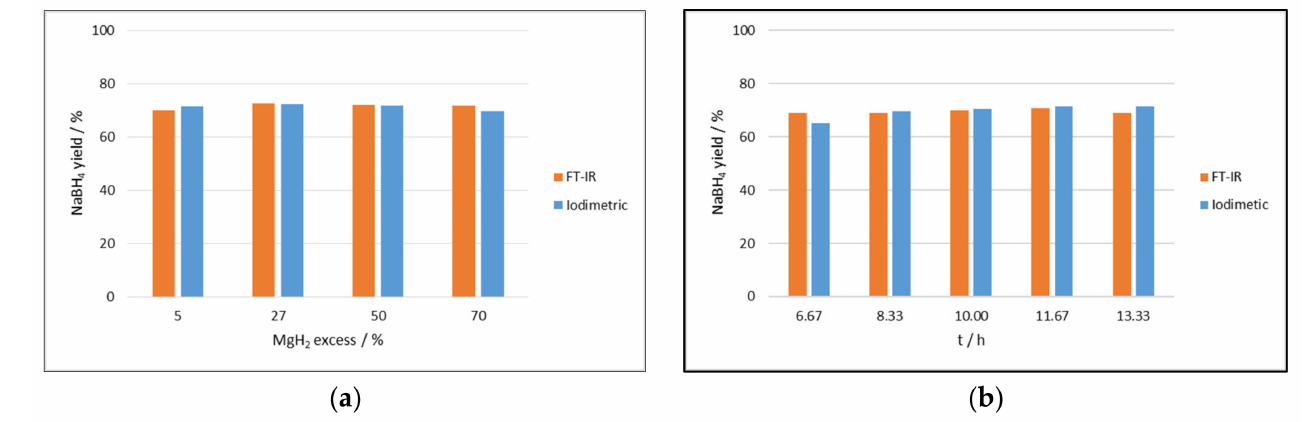
Figure 8. Values of NaBH 4 yield vs. ( a ) excess of MgH 2 and ( b ) t . Adapted from